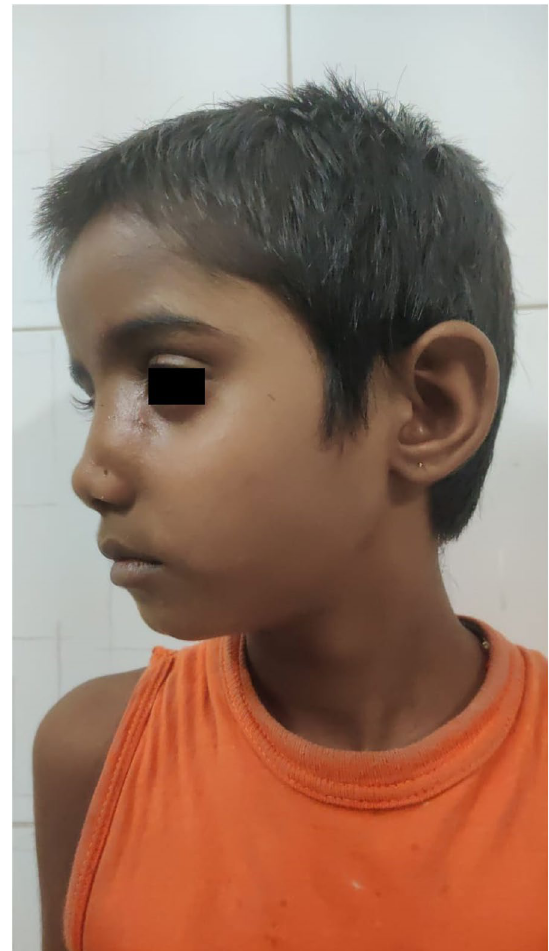
Fig. 1 Pre-op image of the patient showing swelling over left side of nasal cavity and cheek with broadening of nasal bridge